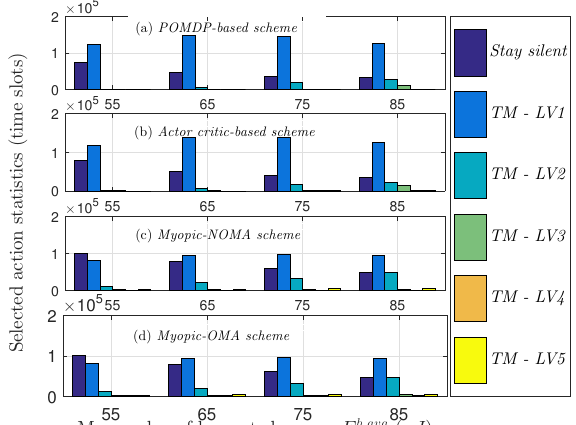
Figure 9. Statistics for the selected actions of the proposed schemes according to the mean value of harvested